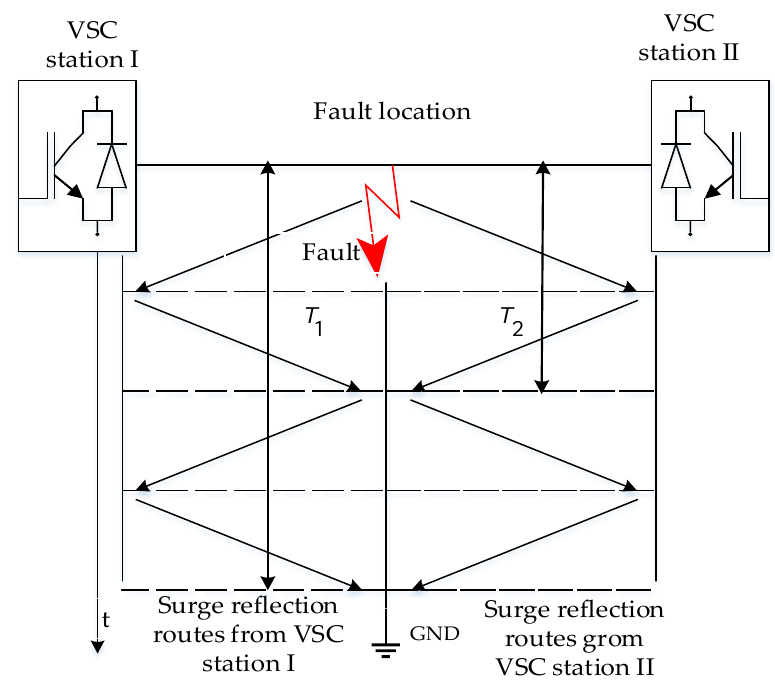
Figure 6. Surge reflection routes in a faulted line.